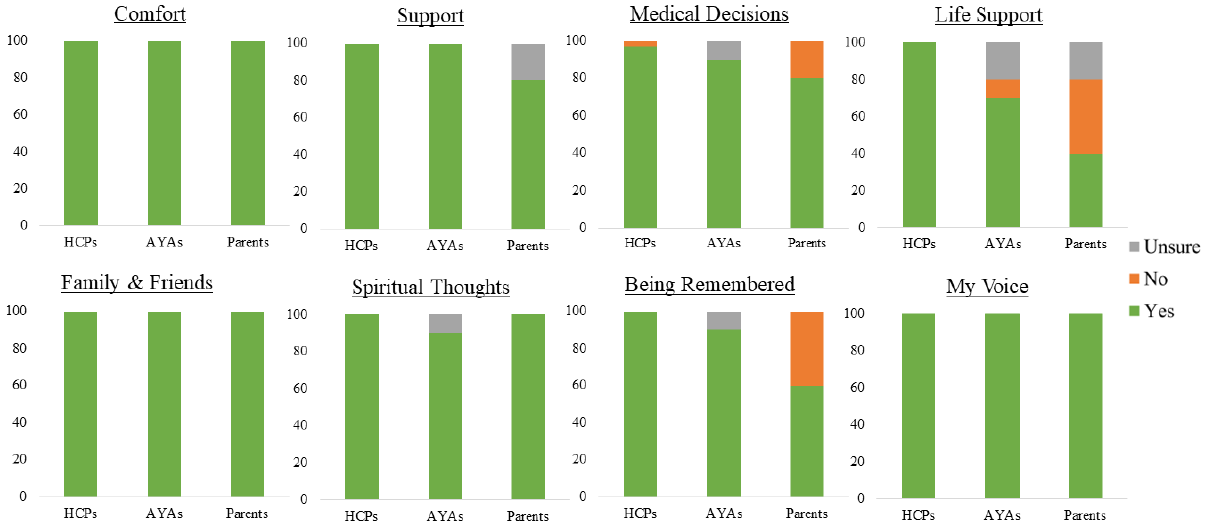
Figure 1. Appropriateness of Voicing My Choices content by section, according to different partici-